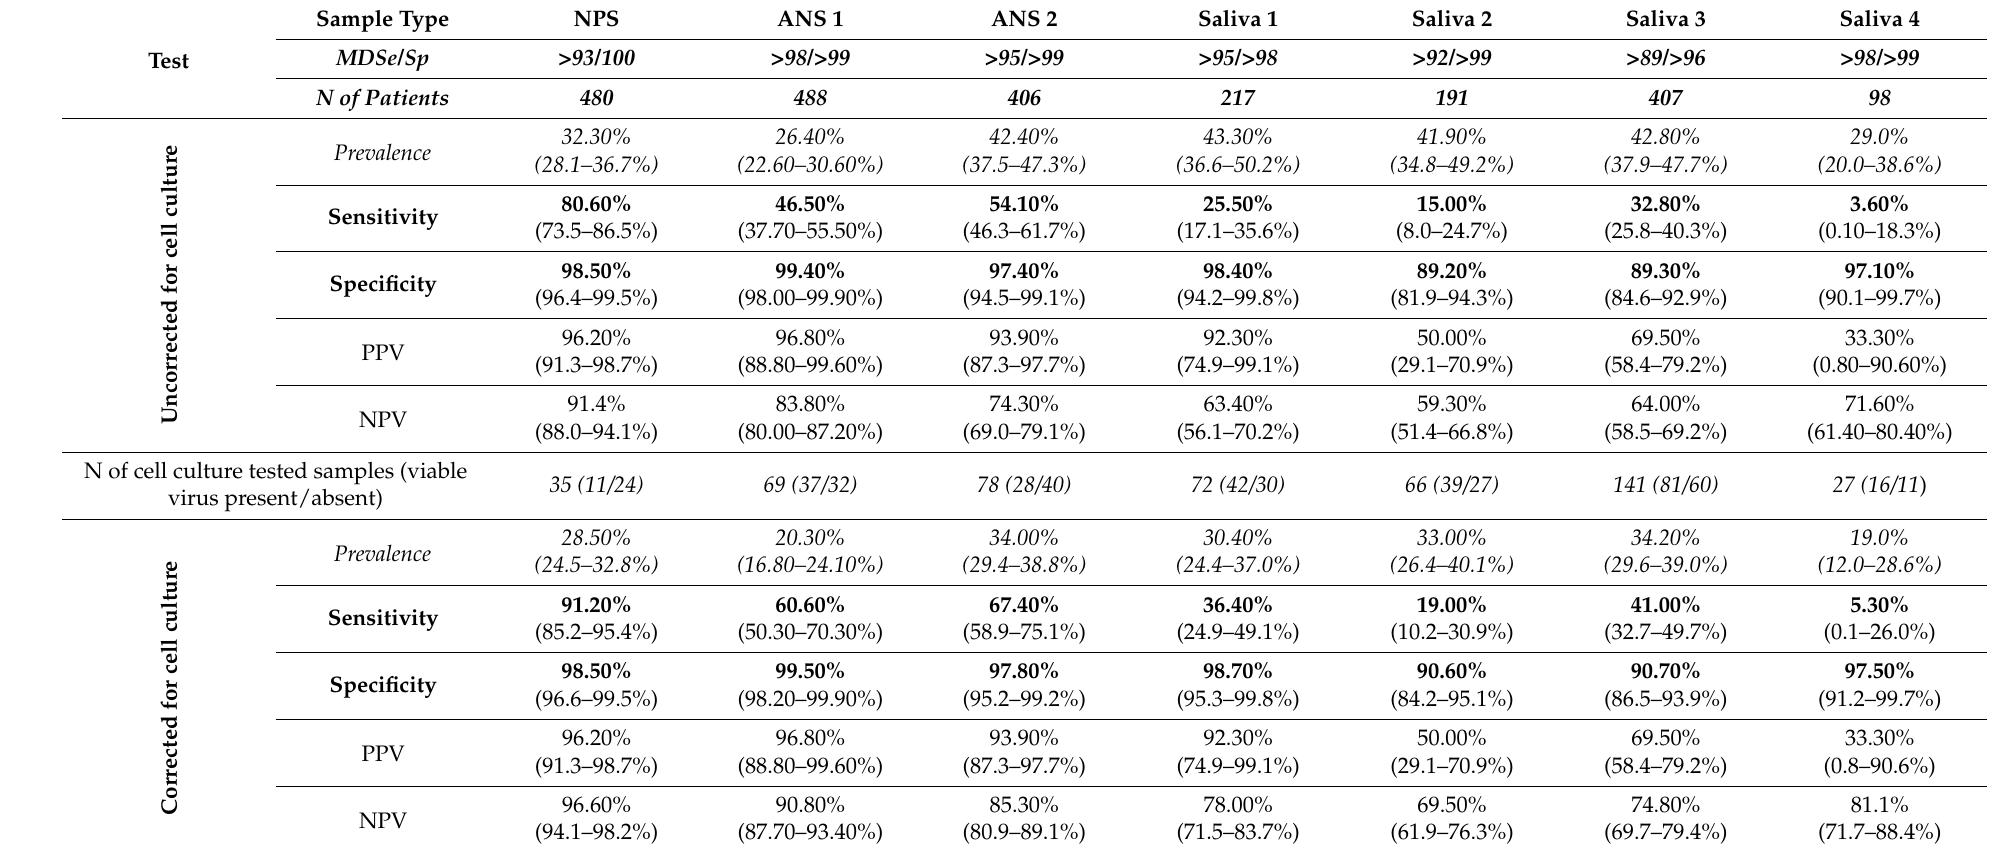
Table 2. Overall real-world performances of 7 RATs; note that only samples where results of RAT and qPCR differed were cell-culture tested; C t -threshold for qPCR positivity is 40; values are presented as parameter estimate (95% confidence interval); MDSe/Sp = manufacturer-declared sensitivity/specificity; NPS–nasopharyngeal swab; ANS–anterior nasal swab; NPV/PPV–negative/positive predictive value; N–number of